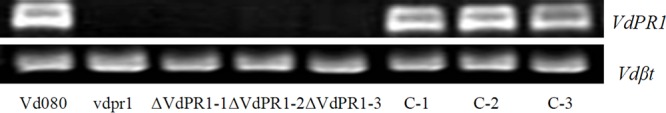
RT-PCR analysis of VdPR1 transcripts in deletion and complementation mutants.Note: The V. dahliae β-tubulin (Vdβt) was used as a control.